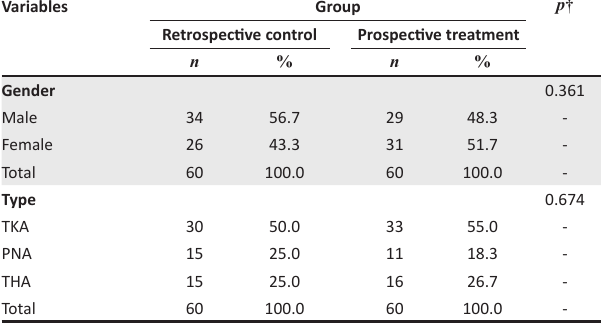
TABLE 2: Patient demographics as per gender and arthroplasty type ( n = 120). Variables